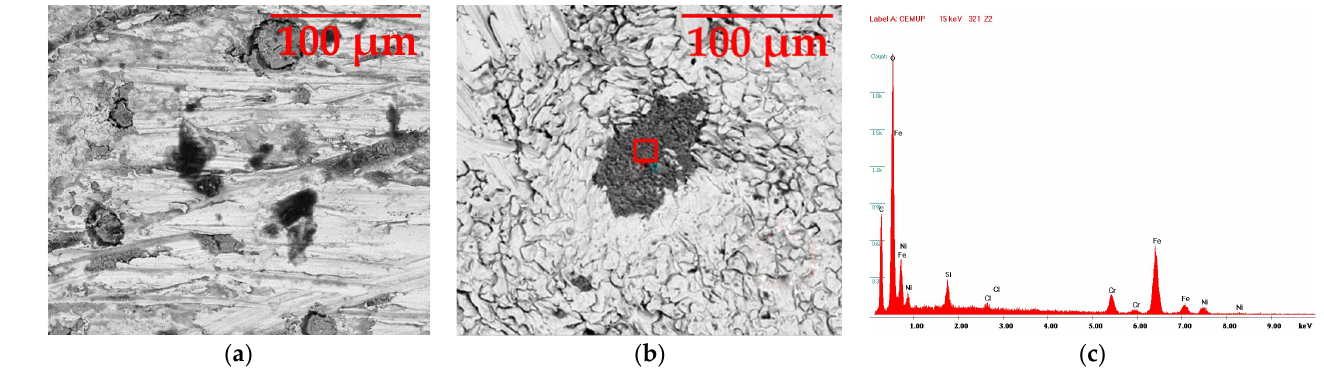
Figure 7. SEM image of the AISI 321 sample with 1000× magnification: ( a ) after three weeks and ( b ) after three months. ( c ) EDS image of the red zone in the second image.